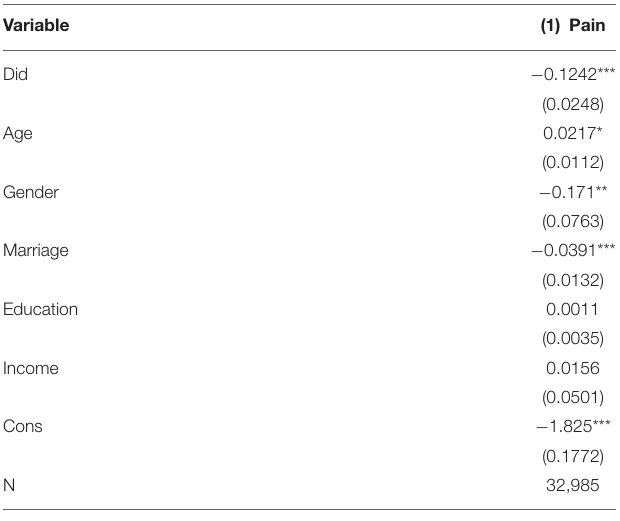
TABLE 8 | DID results with reselection of the dependent variable of pain.